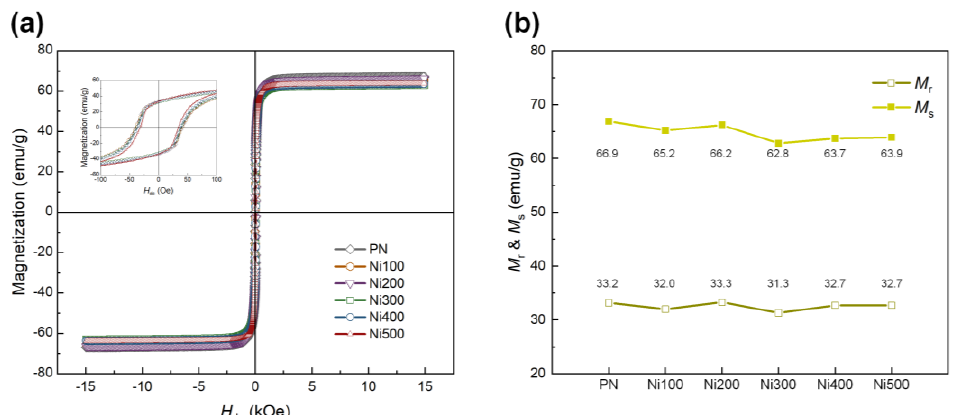
Figure 5. ( a ) M − H hysteresis loops of PN, Ni100, Ni200, Ni300, Ni400, and Ni500 in the range of ±15,000 Oe. The inset shows the small range of magnetization behavior for each sample according to the applied external magnetic field in the range of ±100 Oe. ( b ) Values of M r and M s for each